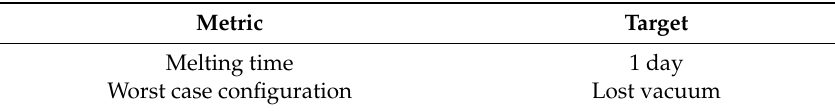
Table 6. Operation target